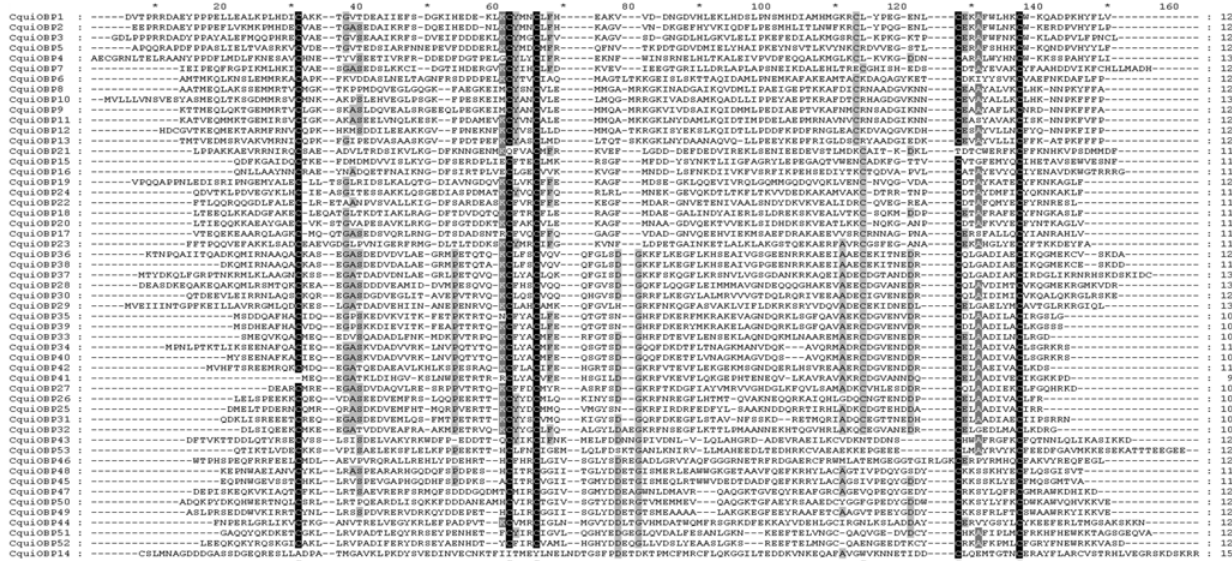
Figure 1. Amino acids alignment of Cx.quinquefasciatus putative OBPs. Residues conservation is indicated by different levels of shading: dark grey: 90% conservation; medium grey: 60% conservation; light gray: 40% conservation. The conserved cysteine residues are indicated by the letter C below the alignment. GenBank accession numbers are available in Table 1. doi:10.1371/journal.pone.0006237.g001 PLoS ONE |